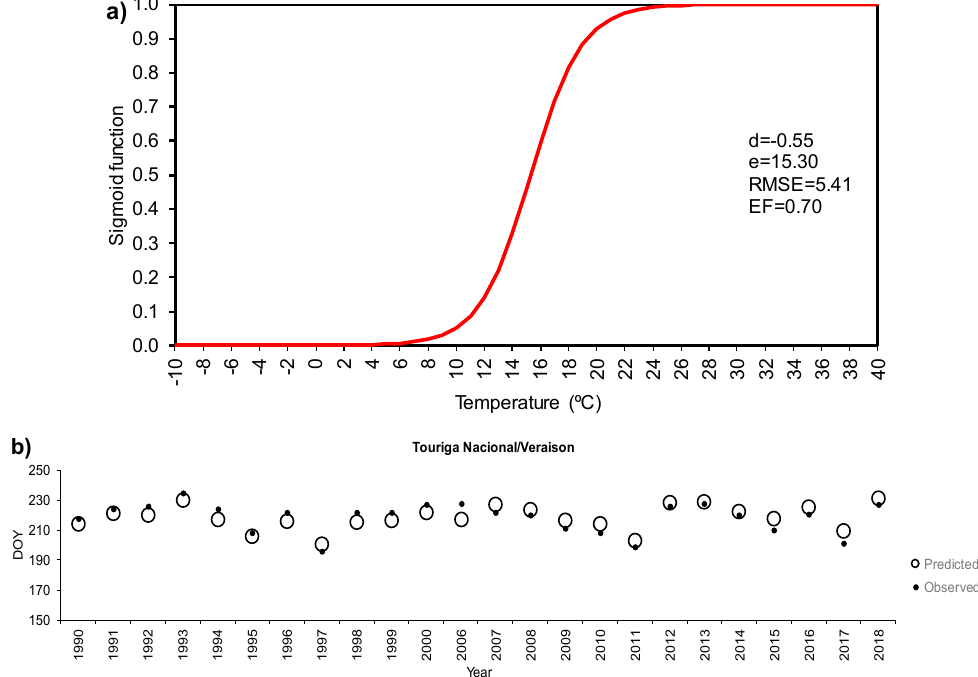
Figure 3. Simulation of the veraison of cv. Touriga Nacional from the Lisboa wine region. ( a ) sigmoid model response function. ( b ) Chronogram of the observed and predicted veraison dates (Julian calendar day of the year, DOY) from 1990 to 2018 (cf. legend).